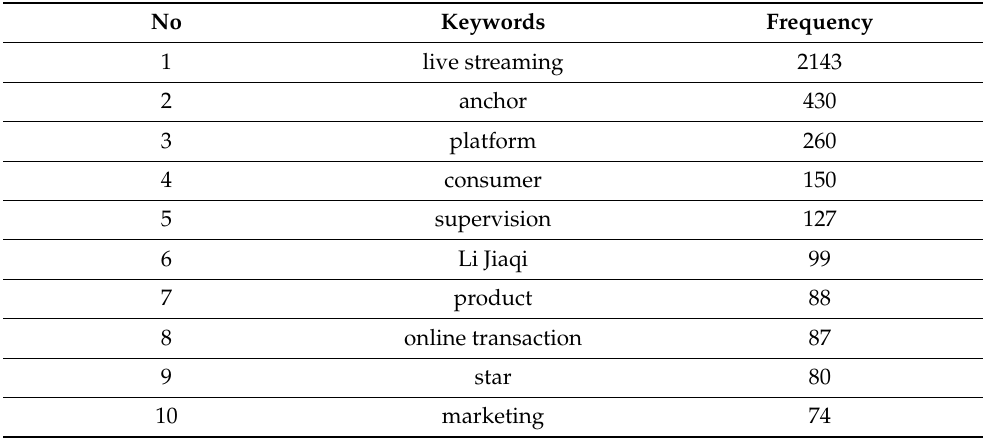
Table 1. Top10 entropy value of